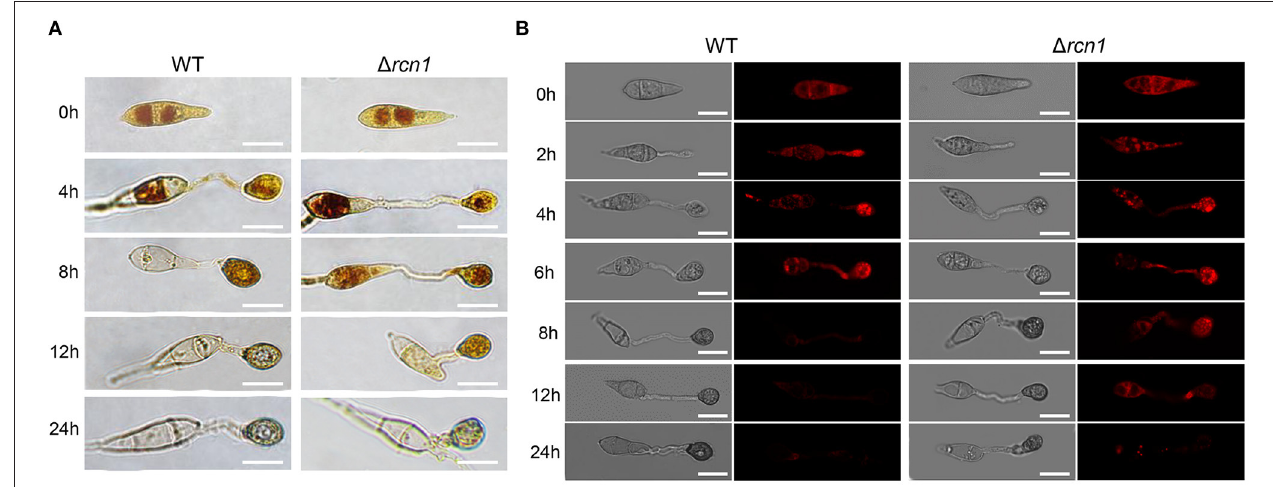
FIGURE 3 | Deletion of MoRCN1 delays the utilization of glycogen and lipid droplets during appressorium formation. (A) Glycogen utilization staining assay. P131 and 1 Morcn1 mutants were stained with KI/I 2 solution at different time points, and yellowish-brown glycogen deposits became visible and were observed using microscopy. Bar 10 µ m. (B) Lipid droplet degradation staining assay. Lipid bodies of conidia were stained with Nile Red at different time points. Bar 10 µ